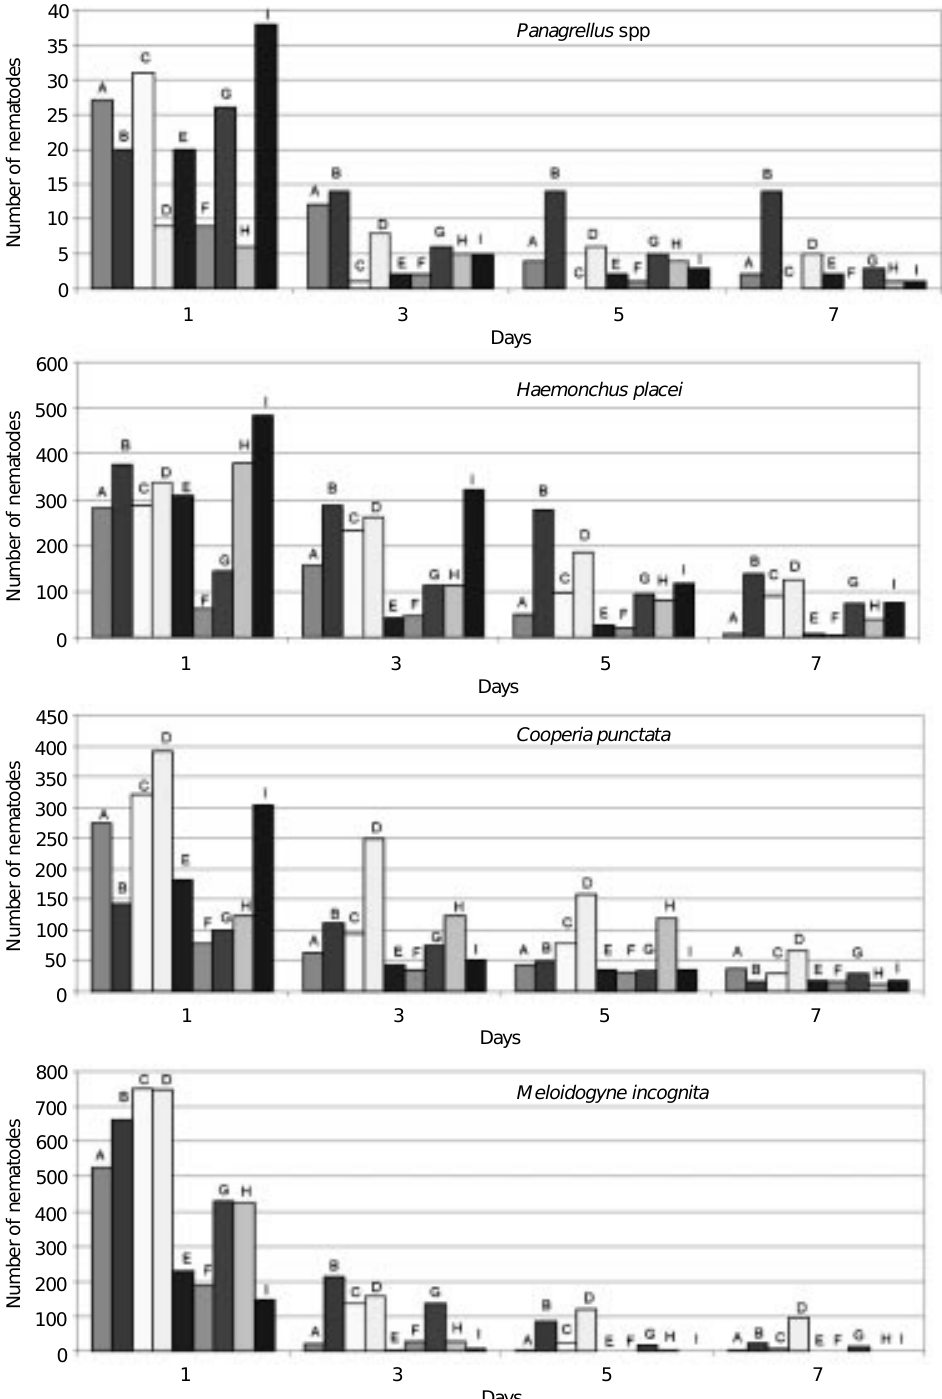
Figure 1 - Susceptibility of nematodes to infection by fungi. Data are reported as number of nematodes free from fungal infection on days 1 to 7 after 2,000 nematodes were exposed to Monacrosporium sinense (isolates A, B, C, D and E), M. appendiculatum (isolates F, G and H) and M. thaumasium (isolate I). Data are the means of measurements in triplicate and control values were ‡ 1970 (98.5%). Note that the abscissae of the four panels are